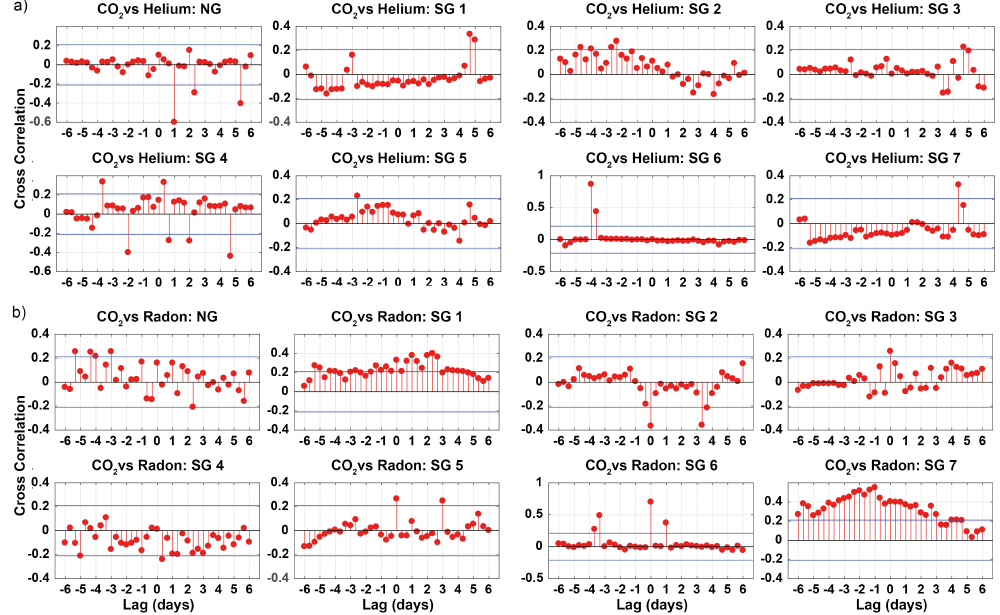
Figure 5. Cross-correlations of time-series of ( a ) CO 2 vs. He and ( b ) CO 2 vs. Rn (8-hour median smoothed) in NG and SG from the 4-W samples. Blue dashed lines indicate confidence